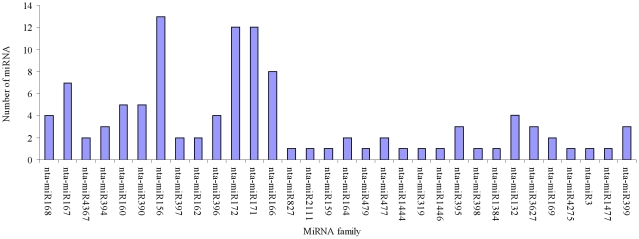
Distribution of conserved miRNA families in tobacco roots.